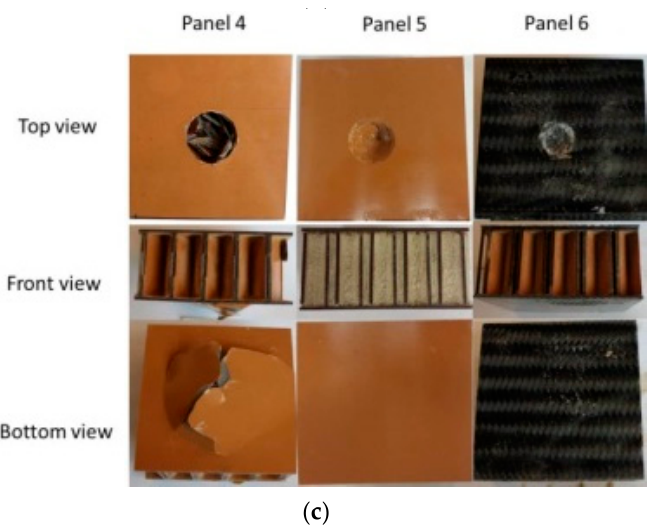
Figure 4. ( a ) Typical load and accumulated absorbed energy vs. displacement curves using 120 J impact energy; ( b ) Typical load and accumulated absorbed energy vs. impact time curves using 120 J impact energy; ( c ) Observed failure of three panel types after the impact test.